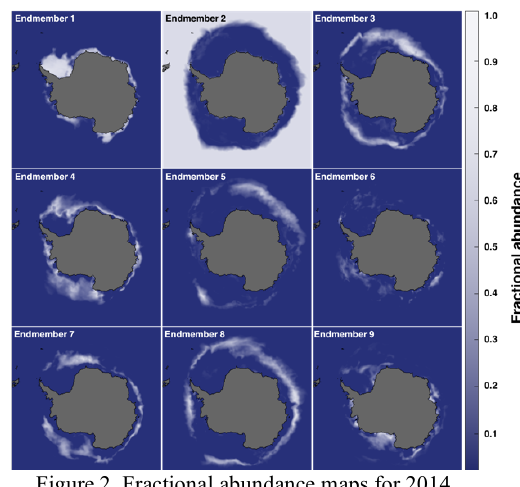
Figure 2. Fractional abundance maps for 2014